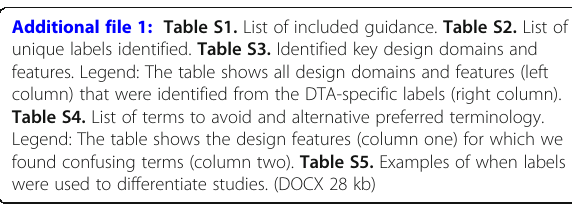
Abbreviations DAC: Diagnostics Advisory Committee; DAP: Diagnostic